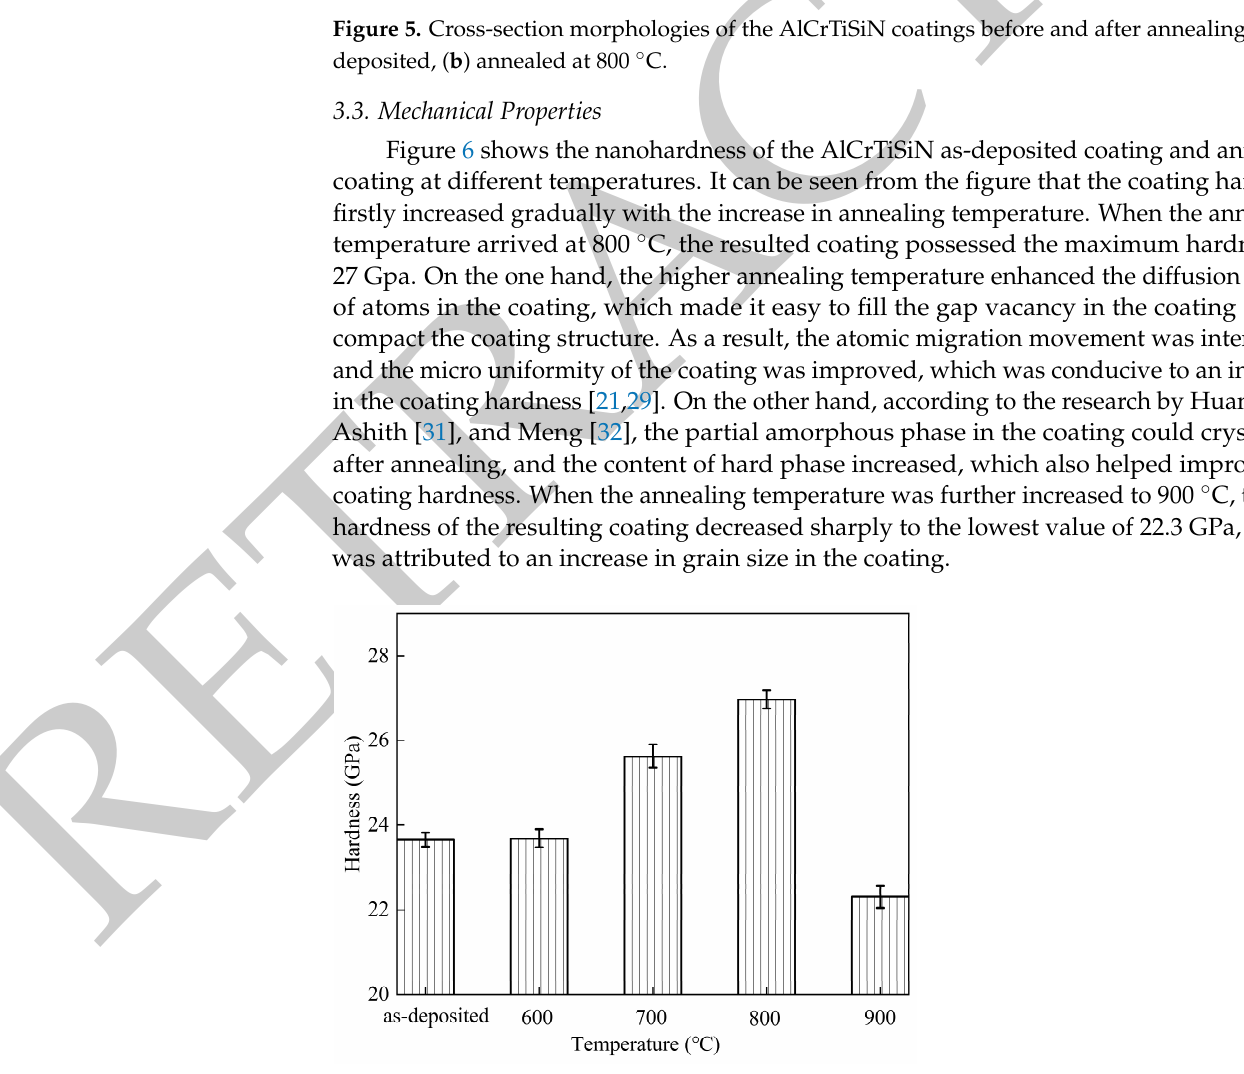
Figure 6. Nanohardness of the AlCrTiSiN coatings before and after annealing at different tempera- tures.